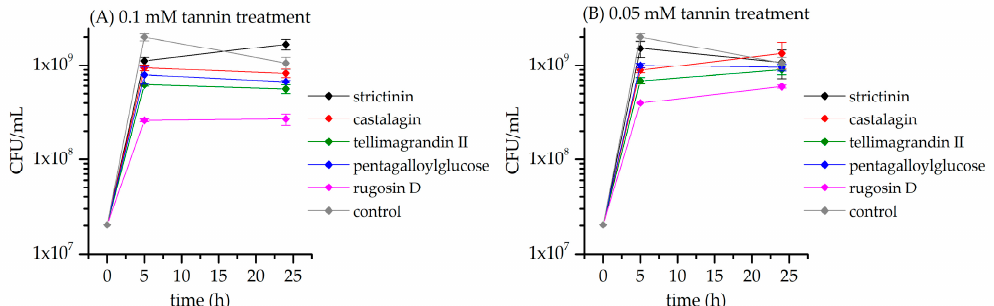
Figure 11. Growth of E. coli 5 h and 24 h after treatment with ( A ) 0.1 mM and ( B ) 0.05 mM hydrolyzable tannin. Control culture was not treated with hydrolyzable tannins. Bacterial growth is presented as colony-forming units (CFUs) per mL (mean and standard error, n = 3).